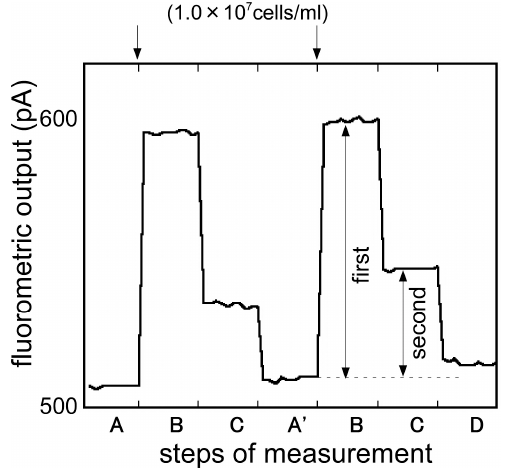
Figure 9. Typical responses of repetitive immunosensor to E. coli O157:H7 (1.0 × 10 7 cells/mL).